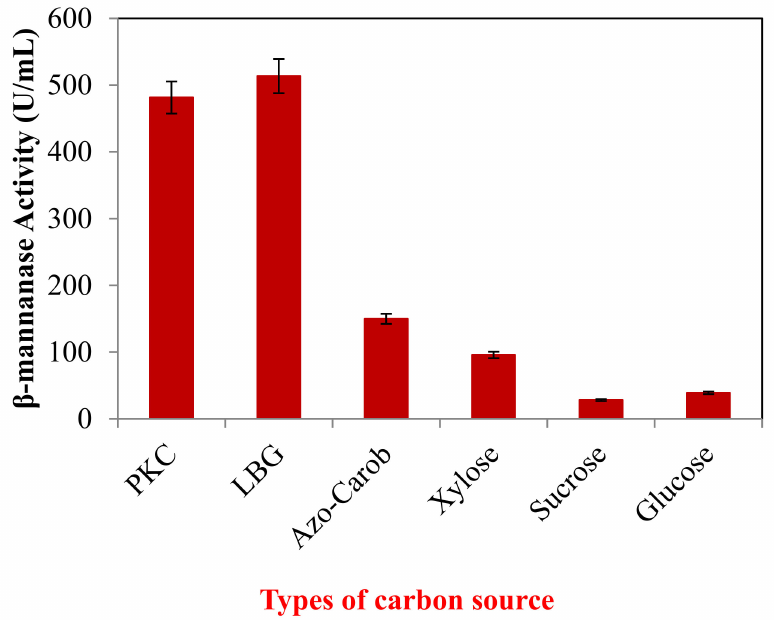
Figure 1. Di ff erent types of carbon sources in modified nutrient broth medium on β -mannanase production. PKC = Palm kernel cake, LBG = locust bean gum, Azo-Carob = Azo-Galactomannan from carob. The results are expressed as the means of triplicate readings with an estimated error of ±